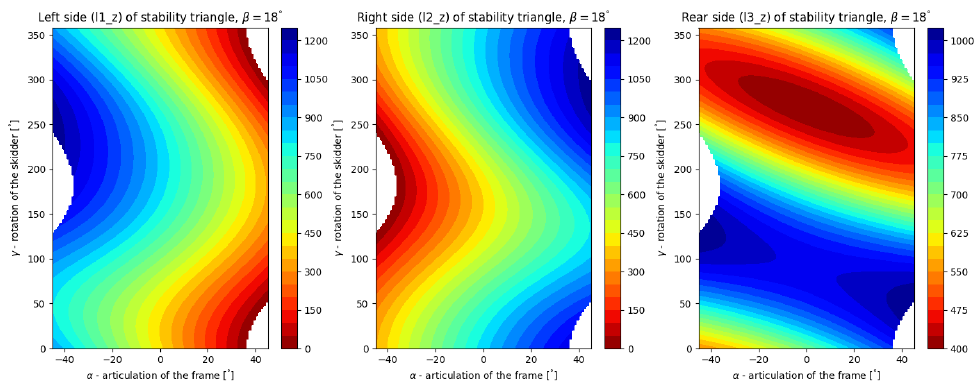
Figure 9. Firefighting device stability for full water tank (2000 L) behind rear axle, and additional weight (500 kg) in the front (C4 configuration).